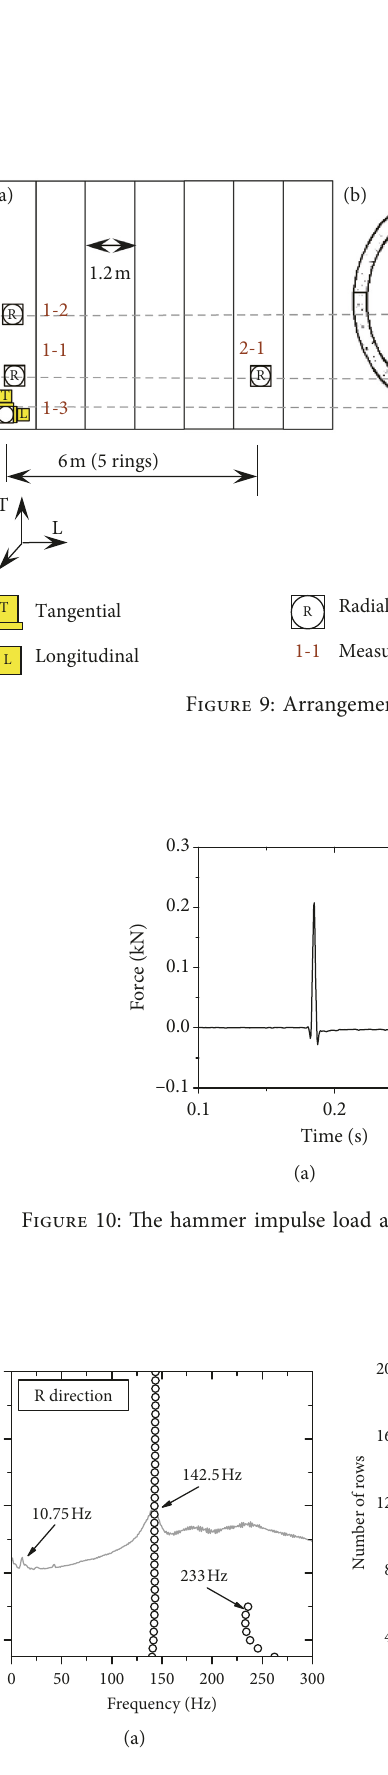
Figure 11: The stability diagrams of the response by applying impulse along different directions at the subway tunnel: (a) radical; (b) longitudinal; (c) tangential directions.